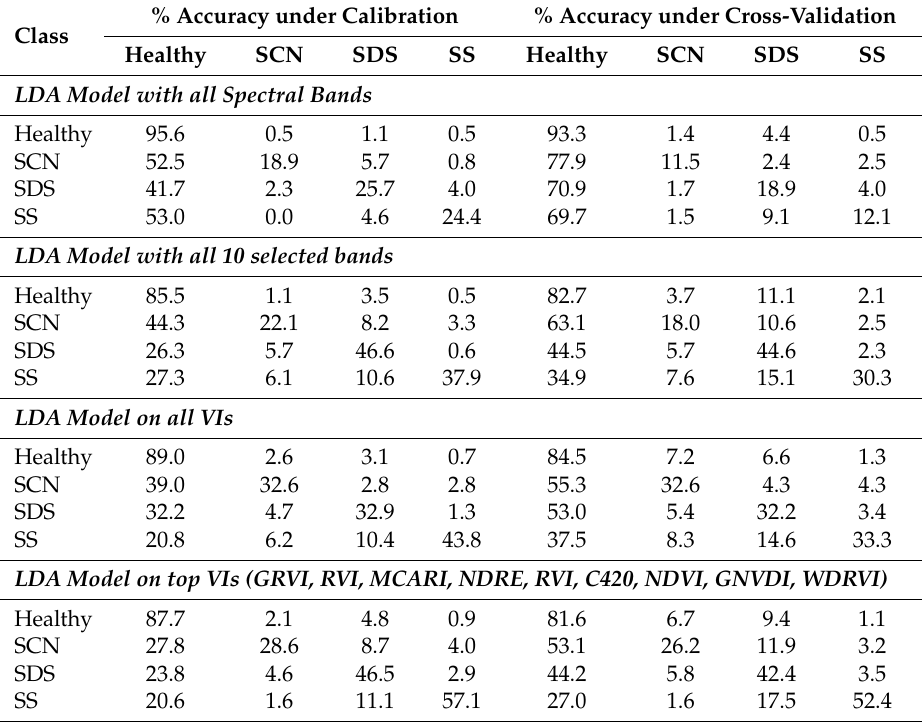
Table 6. Classification accuracy with Linear Discriminant Analysis (LDS) performed on reflectance data with all bands and 10 best bands identified in Table 4 as well as all vegetation indices (VI) and the 10 best VI.